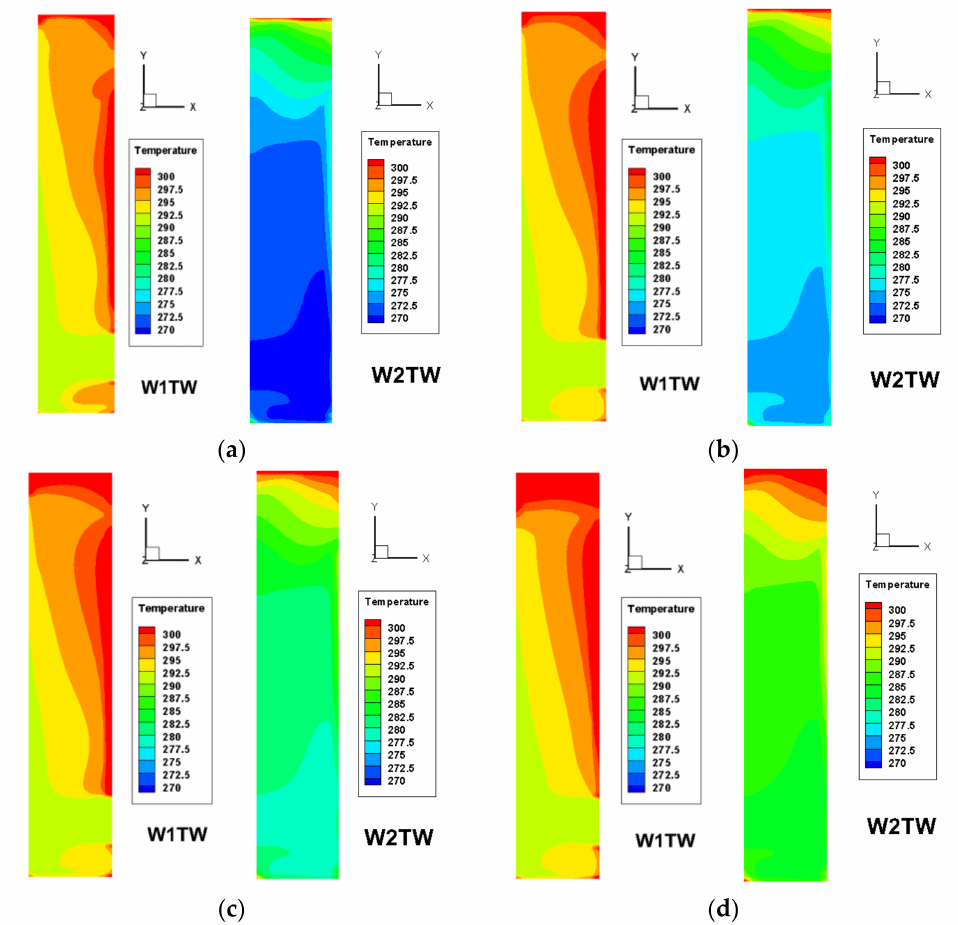
Figure 6. The temperature distributions in the winter: ( a ) Ta = 268 K; ( b ) Ta = 273 K; ( c ) Ta = 278 K; and ( d ) Ta = 283 K. (For all heat maps, the left boundary is the glass cover and the right boundary is the